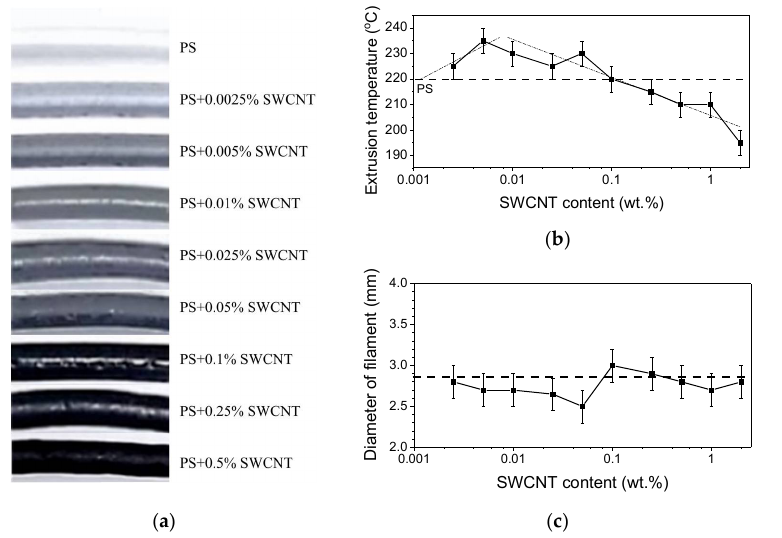
Figure 2. Images of PS filaments with different SWCNT concentrations ( a ), dependence of extrusion temperature ( b ), and diameter ( c ) of filament on SWCNT content.